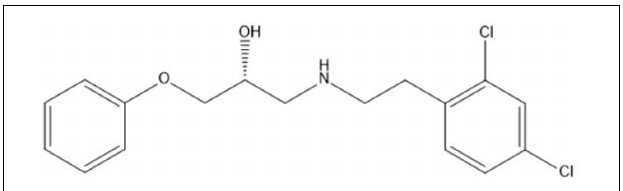
FIGURE 1 | Chemical structure of the propanol-amine derivative 1-((2,4-dichlorophenethyl)amino)-3-phenoxypropan-2-ol